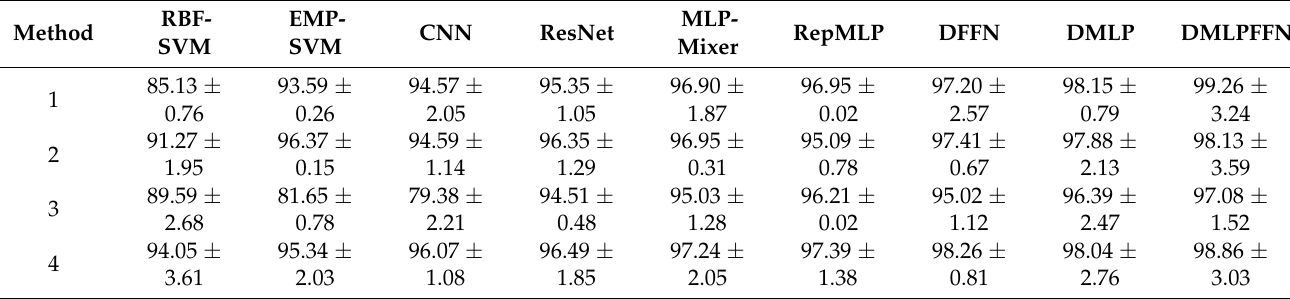
Table 3. Classification results on the Salinas dataset by different classification